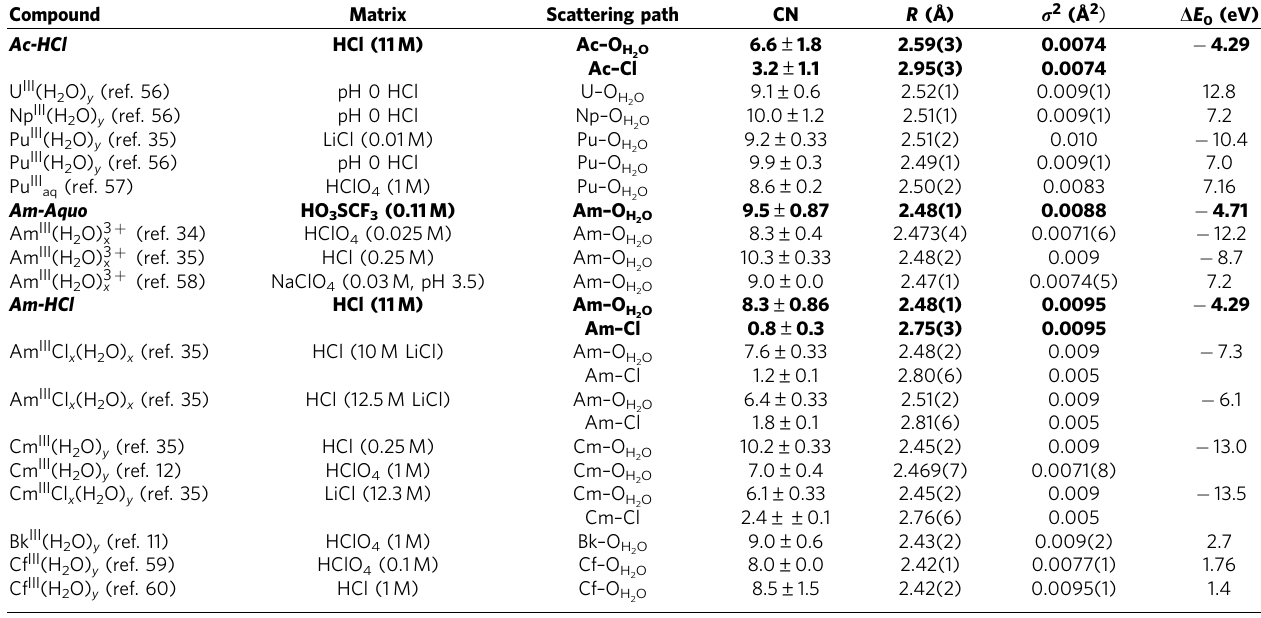
Table 1 | Structural parameters determined using solution-phase EXAFS. Compound